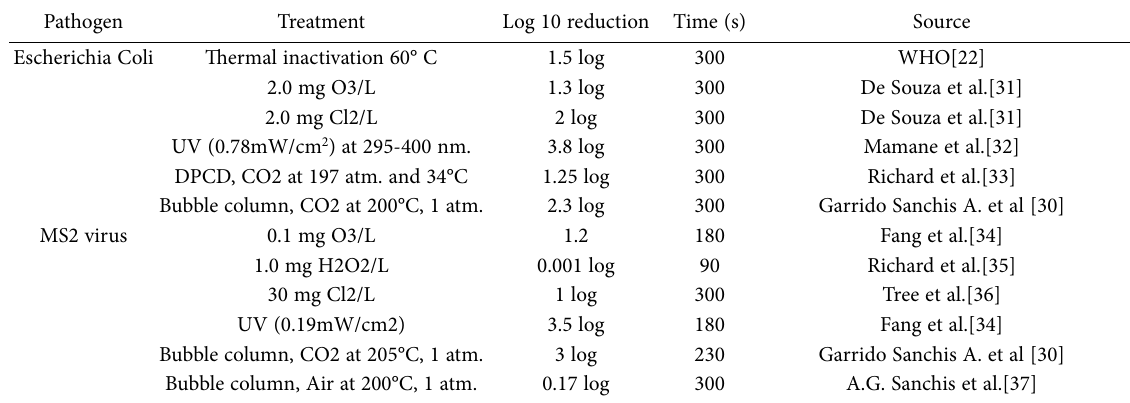
Table 8. Summary of studies of inactivation of E.coli and MS2 virus with different technologies [30]. Pathogen Treatment Escherichia